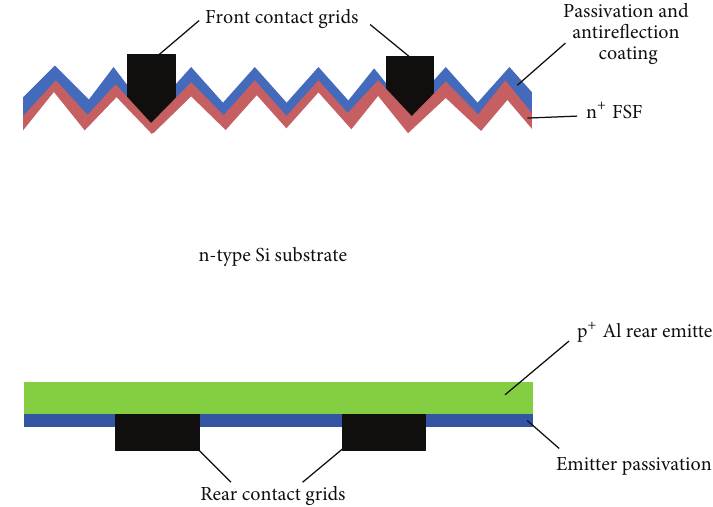
Figure 2: An n + np + Al-rear emitter cells structure.